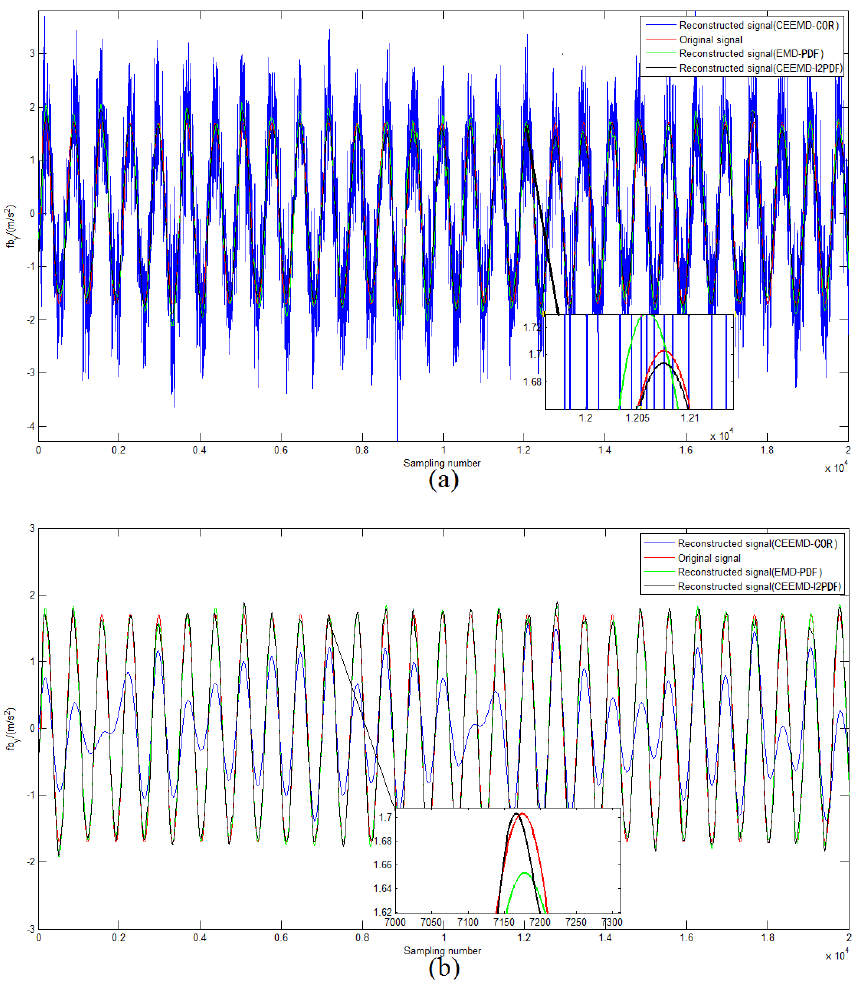
Figure 5. Reconstructed signals by different methods: ( a ) − 2-dB SNR noise signals; ( b ) 4-dB SNR noise